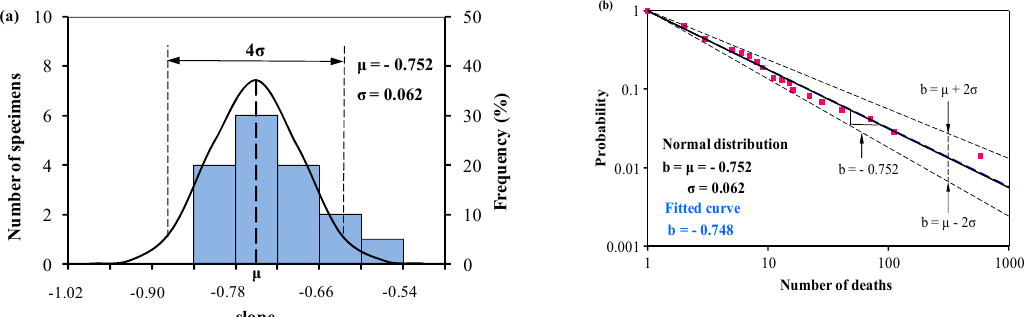
Figure 2. ( a ) Normal distribution analysis of the slope b i determining the relation between the accumulated frequency and number of deaths, and ( b ) predictions from Equation (1) and Equation (3) based on the normal distribution analysis of b i in ( a ) together with the statistical data in rail accidents from 1931 to 2004 available in Oggero et al. [11].